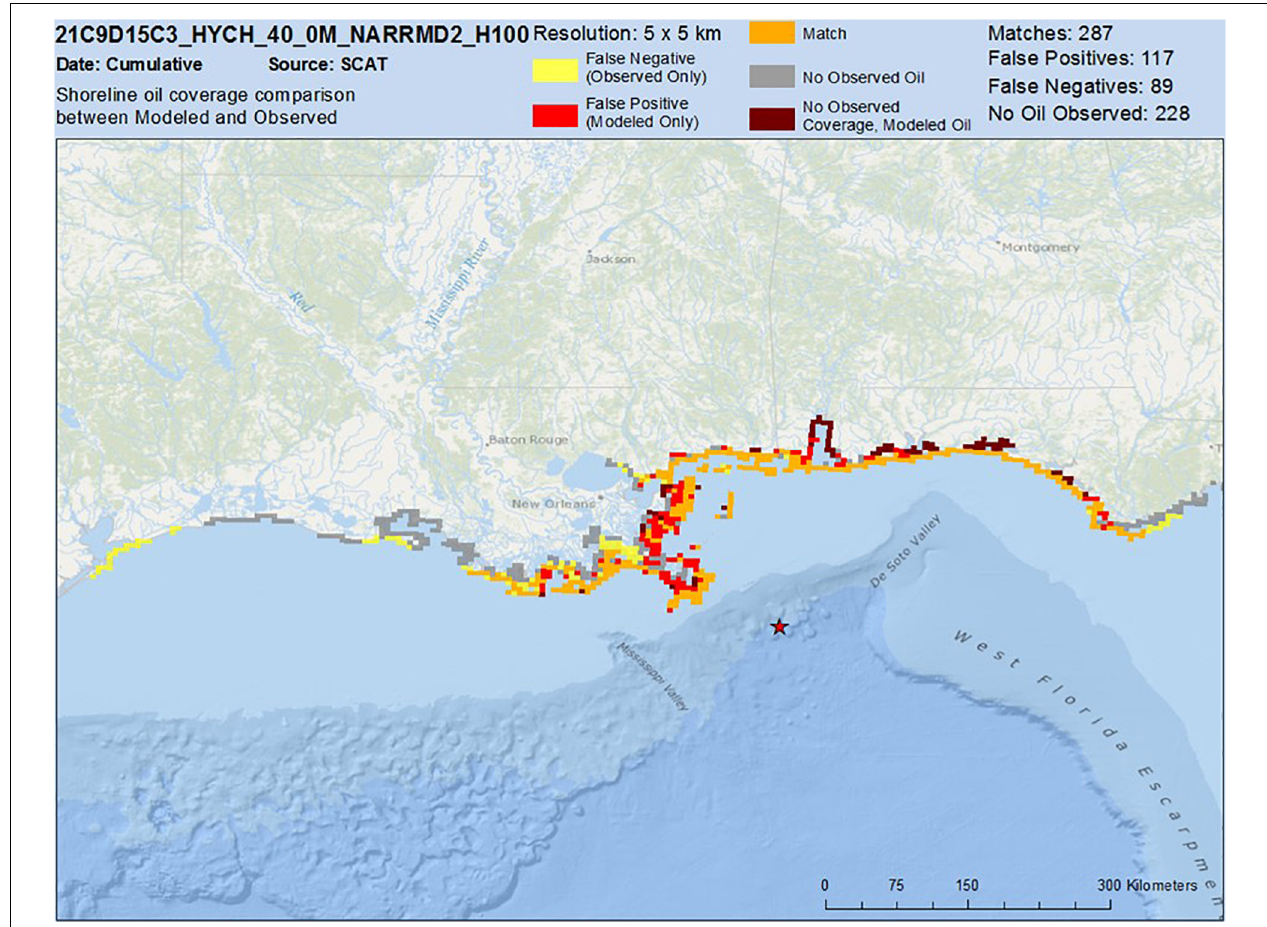
FIGURE 8 | Comparison of model predictions, for the base case simulation using HYCOM-FSU Reanalysis currents and NARR winds, to SCAT-based observations of cumulative amount of oil coming ashore by September 30,